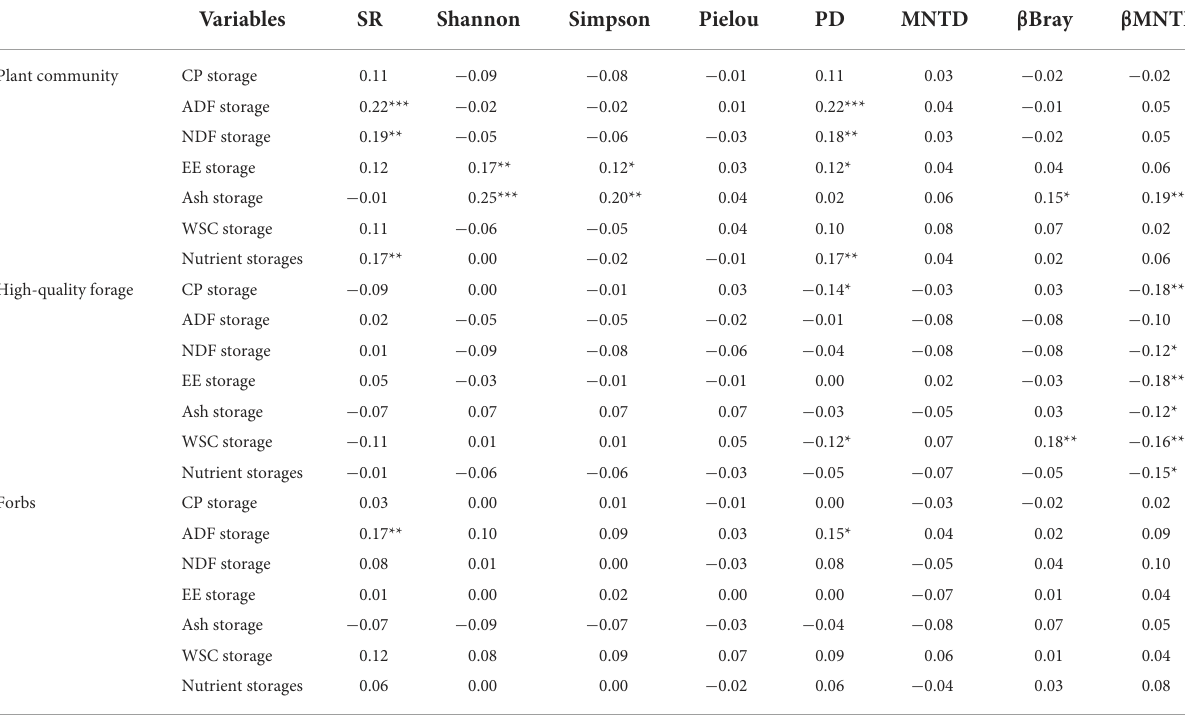
TABLE 3 Correlation analysis between forage nutrient storages of plant community, high-quality forage or forbs, and biotic factors. Variables SR Shannon Simpson Pielou PD MNTD β Bray β MNTD Plant community CP storage